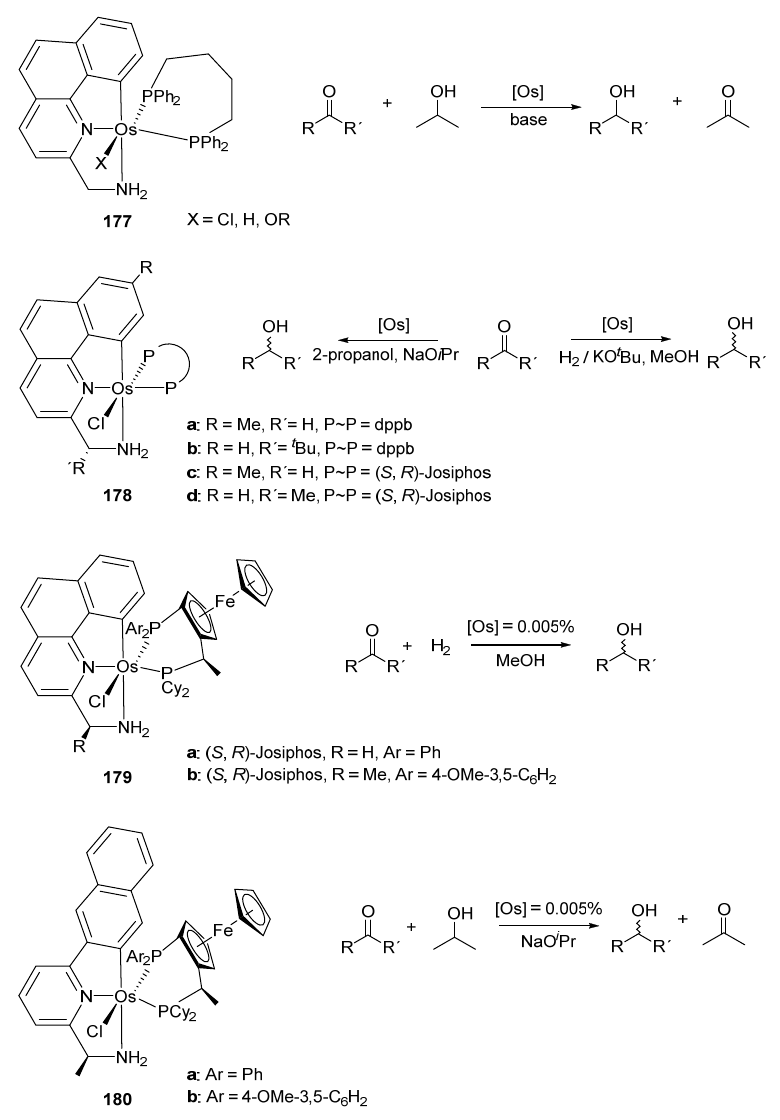
Figure 39. Hydrogenation reactions catalyzed by osmium pincer complexes.